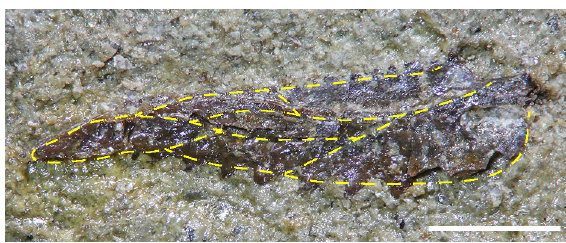
Fig. 11. Microbrachius kedoae from the Gavrilchitsy 45 bore- hole . Distal segment of the pectoral appendage. GIT 767-24. Scale bar = 1